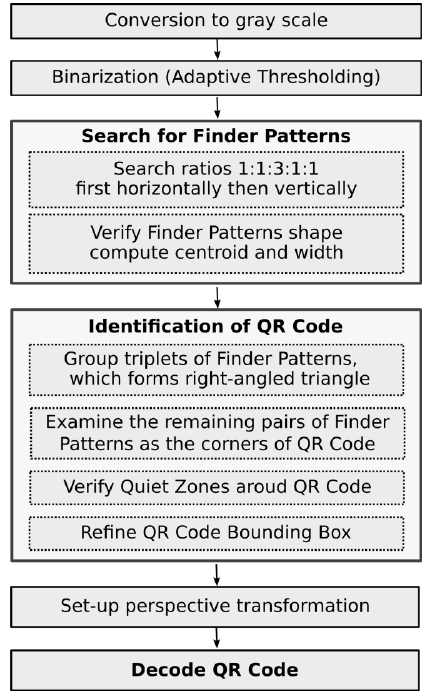
Figure 4. The flow chart of proposed algorithm.